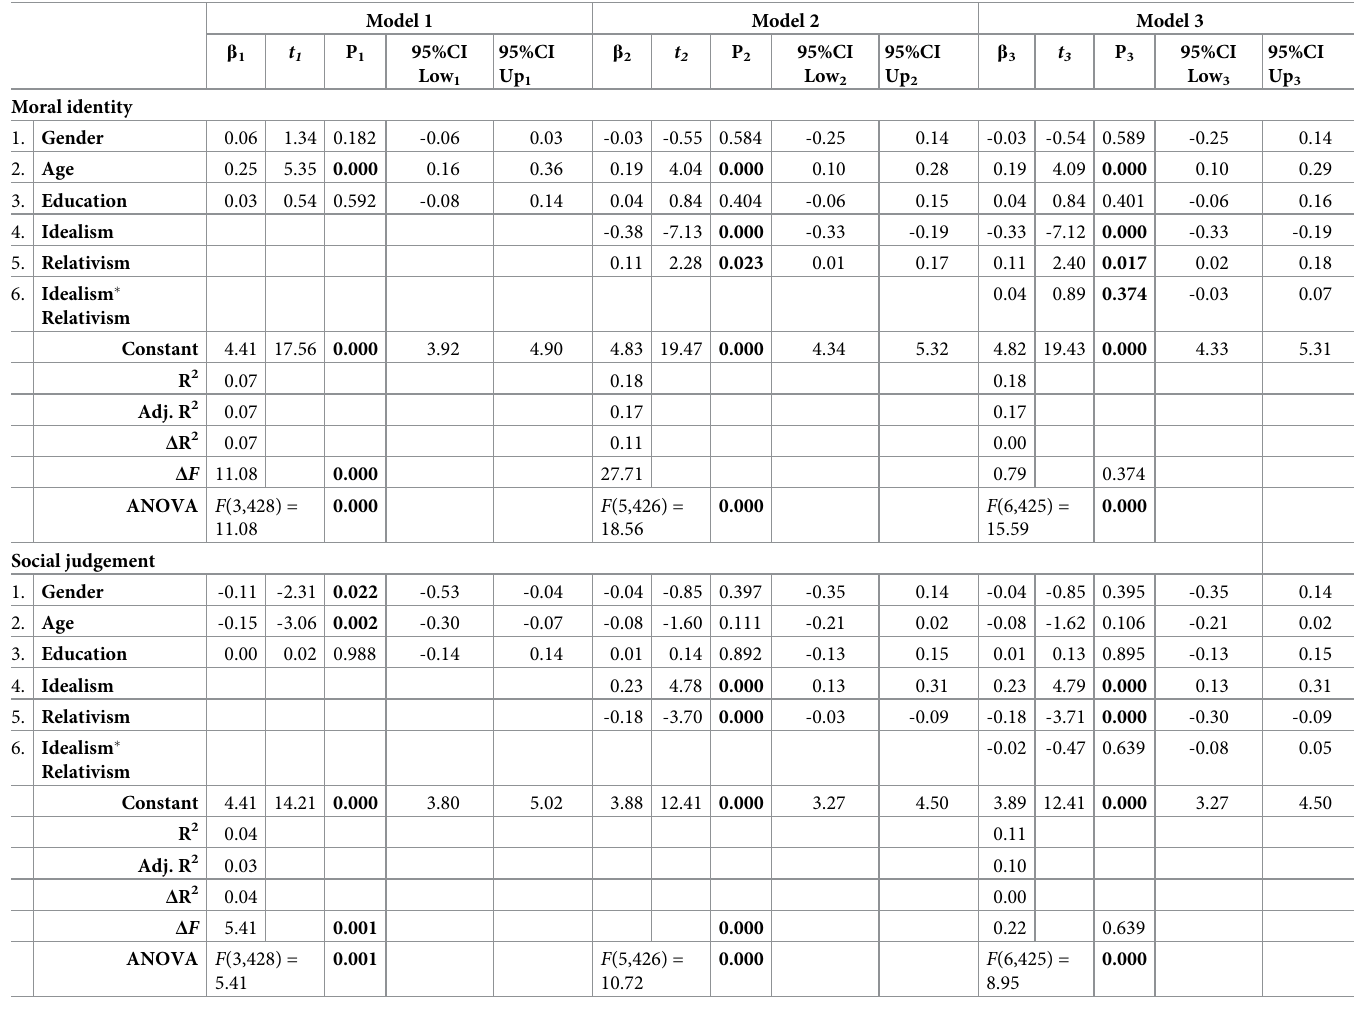
Table 6. Results of hierarchical multiple regression analyses predicting moral identity and social